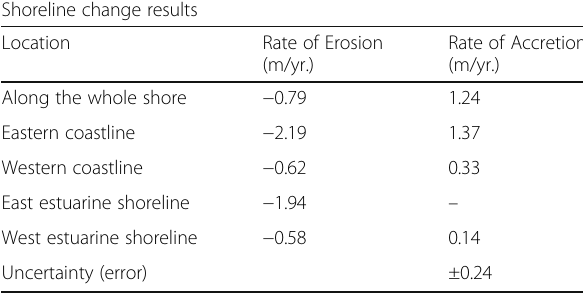
Table 1 Rates of change computed for the various